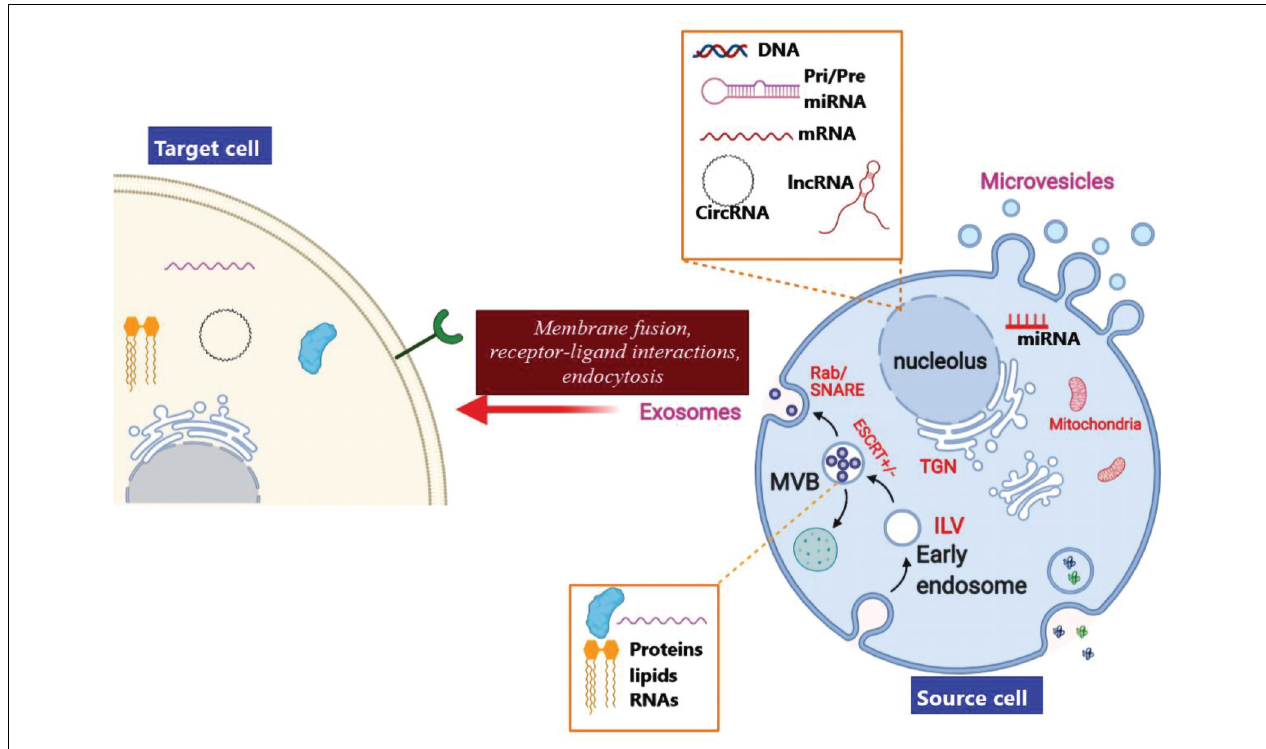
FIGURE 5 | Biogenesis, cargo loading, and secretion of exosomes. Invagination of the endocytic membrane leads to the creation of ILVs and finally to secretion of exosomes. In the course of the maturation process, cargo molecules (proteins, lipids, and RNAs) are loaded into ILVs via an ESCRT–dependent pathway or an ESCRT–independent pathway. Maturation of the initial endosomes results in the formation of MVBs that are transferred to the trans-Golgi network (TGN) in order to recycle the endosomes. The MVBs can also be delivered to the lysosomes for degradation, or moved along micro-tubules for fusion with the plasma membrane in order to release the exosomes into the extra-cellular space. Moreover, MVB fusion with the plasma membrane involves the SNARE and Rab GTPase complexes. Finally, exosomal contents originating from the source cells may be taken up by the target cells via a direct membrane fusion, receptor-ligand interactions, or by